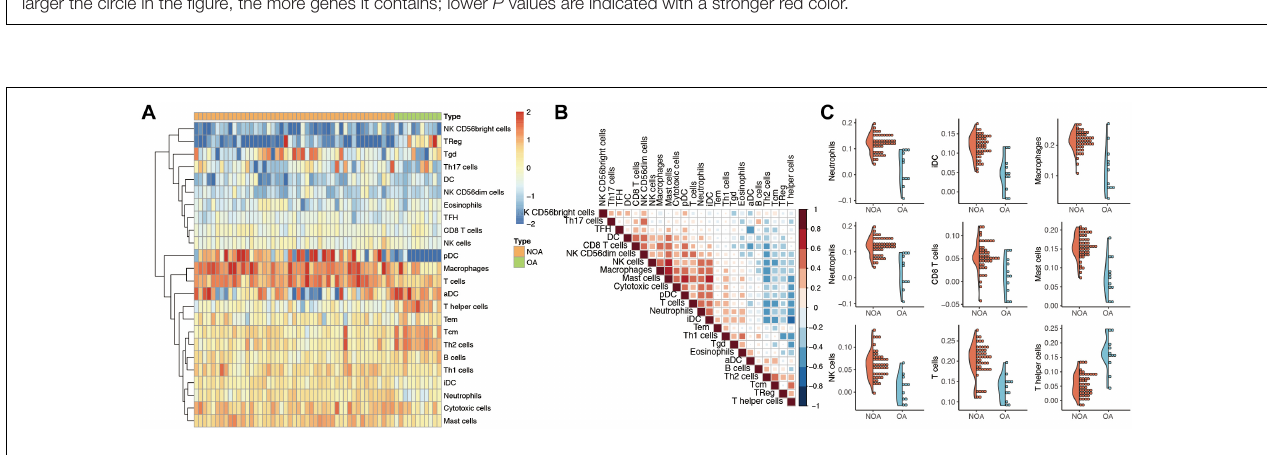
Frontiers in Genetics |